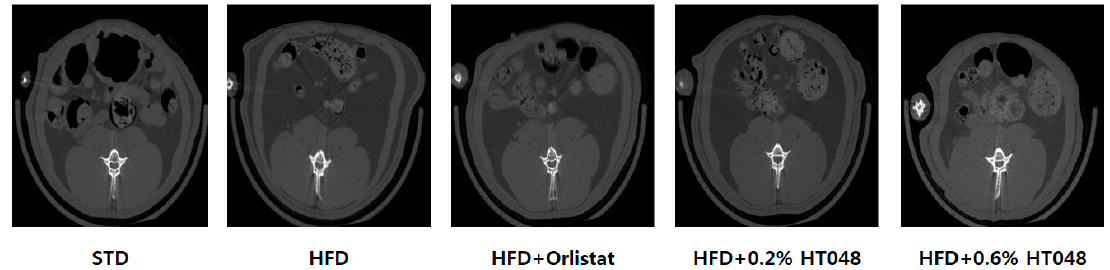
Figure 1. Effect of HT048 on abdominal fat accumulation in HFD-fed obese rats. Representative microCT scanning images of abdominal WAT for each group are shown. White, gray, and black parts roughly indicate bone, muscle or viscera, and fat, respectively.